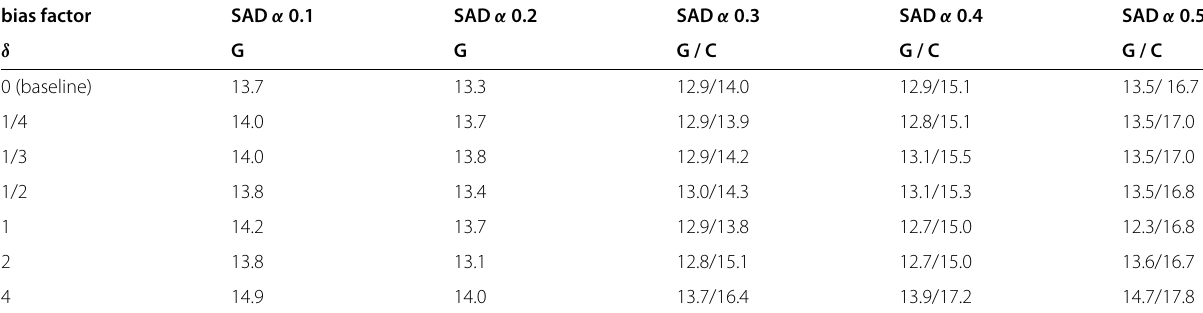
Table 7 A comparison of using different bias factors and SAD dilation-erosion factors on ASR Model 2. WERs are in percent and evaluated on the SAD segmented dev dataset. “G” and “C” represent GMM-HMM aligner and CTC aligner,